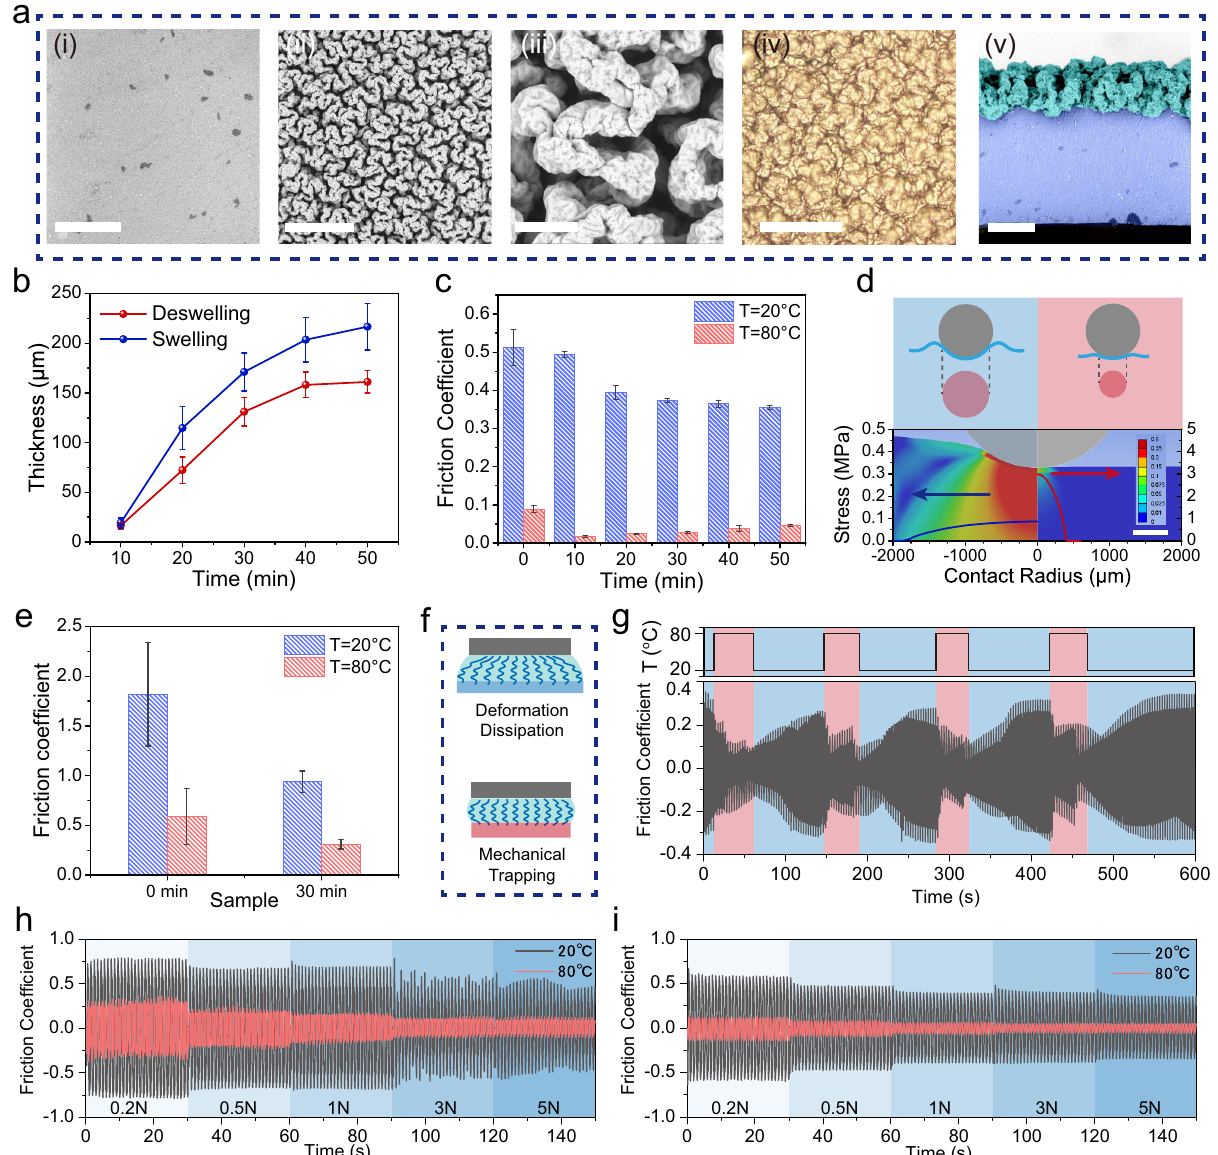
Fig. 4 Responsive lubrication behavior of MALH. a SEM images showing the dry surface morphology of (i) P(AAc-CaAc-co-HEMA-Br) hydrogel (scale bar: 300 μ m), (ii)-(iii) MALH with different grafting time (scale bar: 300 and 50 μ m), (iv) optical microscope photo showing the wet surface morphology of MALH (scale bar: 200 μ m) and (v) SEM image showing the cross-section morphology of MALH (scale bar: 200 μ m). b The relationship between lubricating layer thickness and grafting time of polymer brush of MALH in deswelling state and swelling state, the data were presented as mean ± SD and sample size n = 5. c Friction coef fi cient of MALH samples with different lubricating layer thickness at soft state (20 °C) and rigid state (80 °C), the data were presented as mean ± SD and sample size n = 3. d Schematic diagram showing the contact area of MALH against glass ball, and corresponding interface contact stress analysis result at soft state (blue curve) and rigid state (red curve) and the fi nite element analysis of deformation. Scale bar 1.25 mm. e Friction coef fi cient of P(AAc-CaAc-co-HEMA-Br) hydrogel and MALH (grafting time: 30 min) tested by a typical disk-to-disk contact mode, the data were presented as mean ± SD and sample size n = 3. f Mechanical trapping mechanism of MALH. g Evolution of COF by in-situ heating and cooling MALH (grafting time: 30 min). h , i COF signals for P(AAc-CaAc-co-HEMA-Br) hydrogel and MALH (grafting time: 30 min) at soft and rigid state, along with increasing the